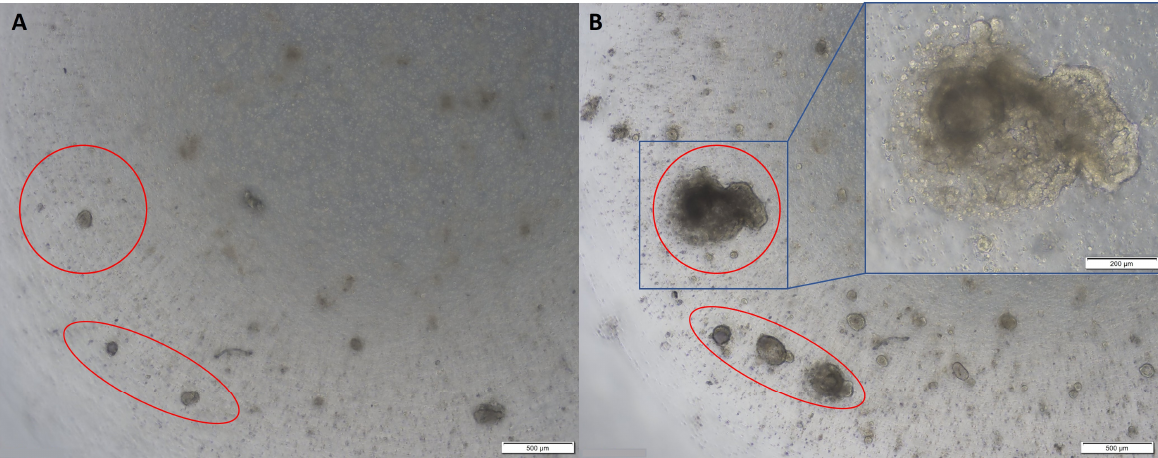
Figure 2. Representative images of colon tumour organoids: ( A ) on day 2 of passage 2; ( B ) on day 10 of passage 2. Original magnification: 4× and 10× (inset).